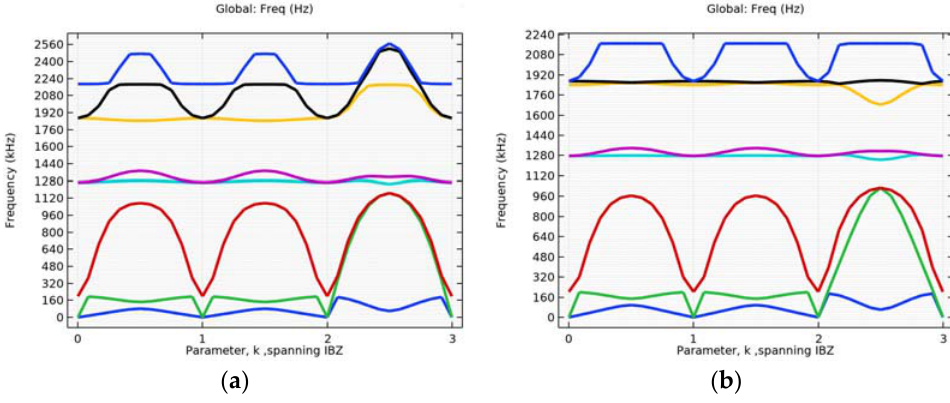
Figure 4. Response along the IBZ of the RVE, for ( a ) with and ( b ) without circular inclusion. The bandgaps that are formed from the geometry with the inner circle, Figure 4a, are two. The first band gap is between the third and fourth eigenfrequencies (1160–1250 Hz) and the second is between the fifth and sixth eigenfrequencies (1370–1840 Hz). Similarly, there are two band gaps located on the diagram of Figure 4b, one between the third and fourth eigenfrequencies (1020–1240 Hz) and the second is between the fifth and sixth eigenfrequencies (1340–1680 Hz).